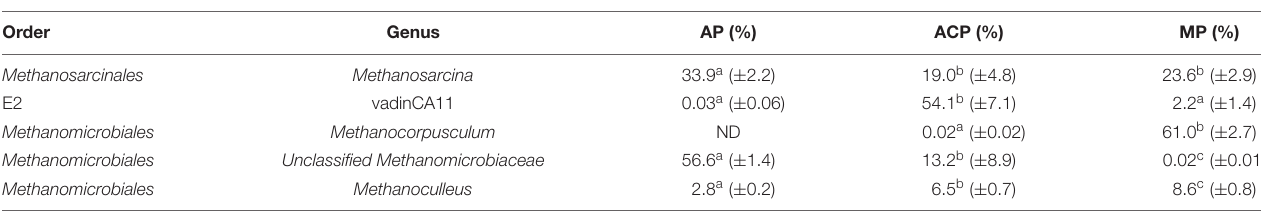
TABLE 1 | Main methanogen genus during solid waste decomposition